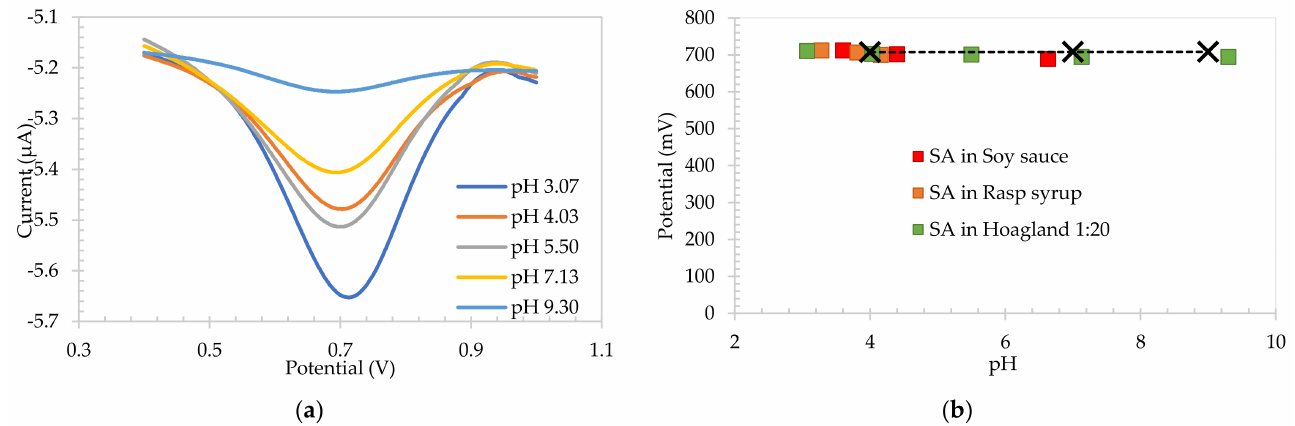
Figure 3. ( a ) Square wave voltammograms of salicylic acid electrodes in diluted Hoagland solution, and ( b ) calibration plot for SA-based electrodes in raspberry syrup, soy sauce, Hoagland and pH 4, pH 7 and pH 9 IUPAC standard